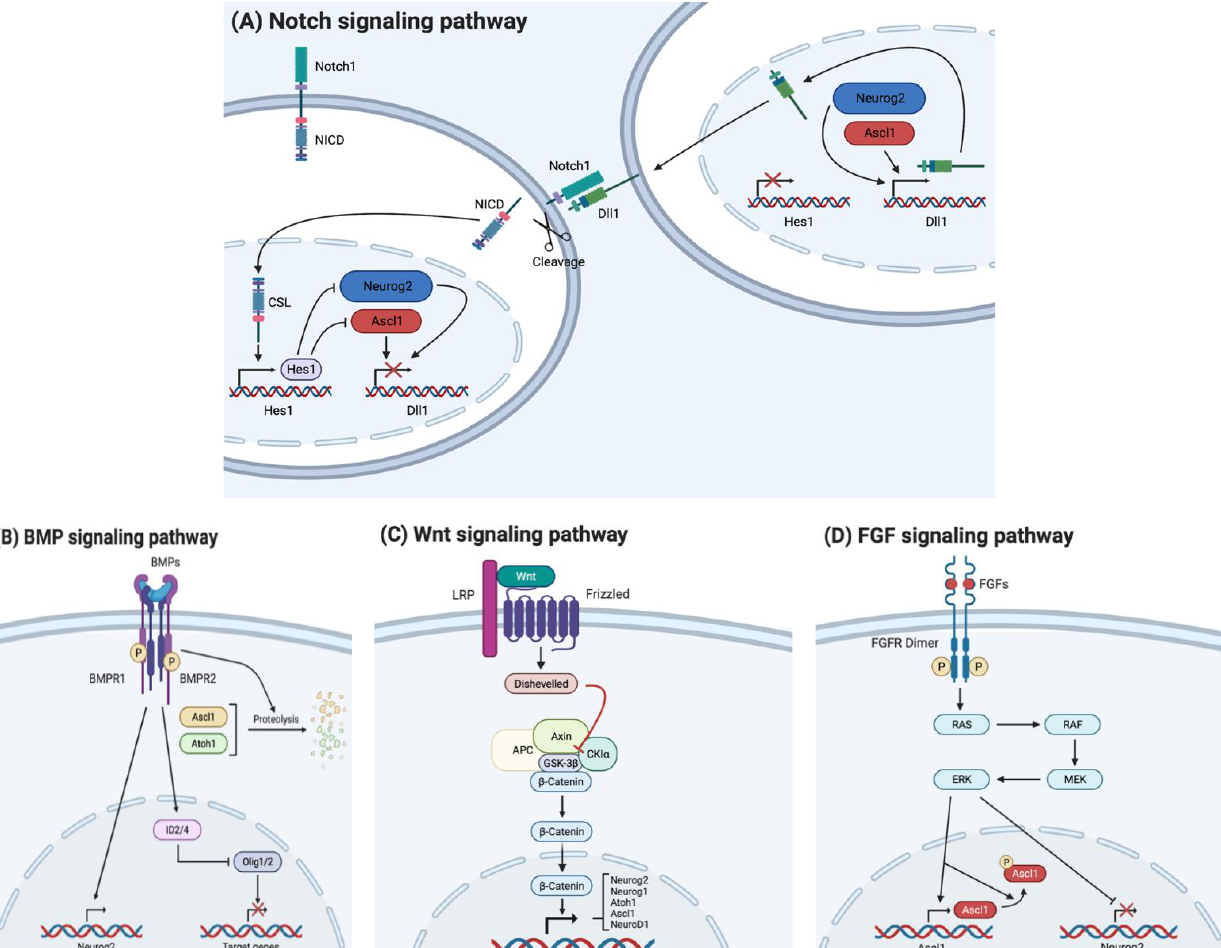
Figure 4. bHLH transcription factors are regulated by a variety of signaling pathways: Notch, BMP, Wnt, and FGF signaling. ( A ) Proneural transcription factors induce the expression Dll1 ligand in the emitting cell ( right ). Dll1 ligand binds to the Notch1 receptor on the receiving cell ( left ), which causes the NICD to be cleaved and translocated to the nucleus. After translocation to the nucleus, NICD interacts with CSL to initiate the transcription of Hes1 , which inhibits the expression of proneural genes. ( B ) BMP ligand binds to serine-threonine kinase receptors, BMP receptors, which initiate the expression of Neurog2 and repress the expression of Oilg1/2 through activation of ID2/4. Simultaneously, Ascl1 and Atoh1 are broken down by proteolysis. ( C ) Interaction of Wnt with the transmembrane receptor, frizzled ( FZ ) and low-density lipoprotein receptor (LRP) activates disheveled (DVL), which can induce the release of β -catenin from the β -catenin destruction complex (stabilization). After the stabilization of β -catenin, it translocates to the nucleus to initiate the expression of numerous bHLH genes. ( D ) FGF ligand binds to receptor tyrosine kinase (RTK) to induce dimerization which activates RAS, RAF, MEK, and ERK signaling. These signaling cascades induce the expression of Ascl1 and repress the expression of Neurog2